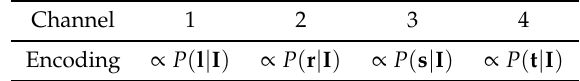
Table 1. Channels 1–4 of the image-space representation used to represent pig locations and orientations. Each channel corresponds to a different body part. The locations of each part are marked with Gaussian kernels meant to represent the distribution of part locations provided by a human annotator.